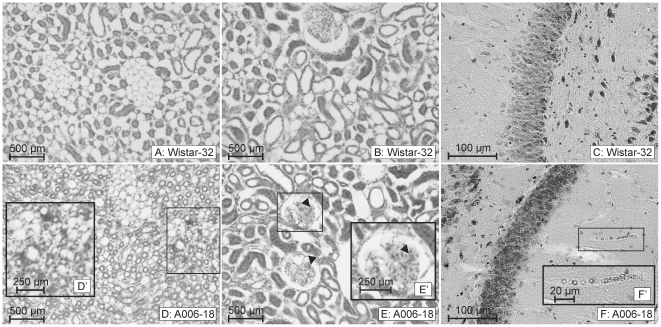
Kidney and brain morphology of a control and SHRSP with few cerebral erythrocyte accumulations.Both the kidney medulla (A) and cortex (B) of a 32 weeks old Wistar rat are free of peritubular erythrocyte aggregations, tubular protein cylinders, glomerulosclerosis and thrombotic microangiopathy which corresponds to normal brain morphology (here hippocampus, C). In contrast the kidney of an 18 weeks old SHRSP (animal 6) shows a few erythrocyte aggregations in medullar peritubular capillaries (D
&
D') and erythrocyte sticking (black arrow heads in
E
&
E') in few glomeruli (E
&
E'). This pathology corresponds to mild erythrocyte accumulations (beginning stases) within some capillaries of the brain (here hippocampus, F
&
F'). Wistar-32: wistar control, 32 weeks old; A006-18: animal number 6, 18 weeks old.